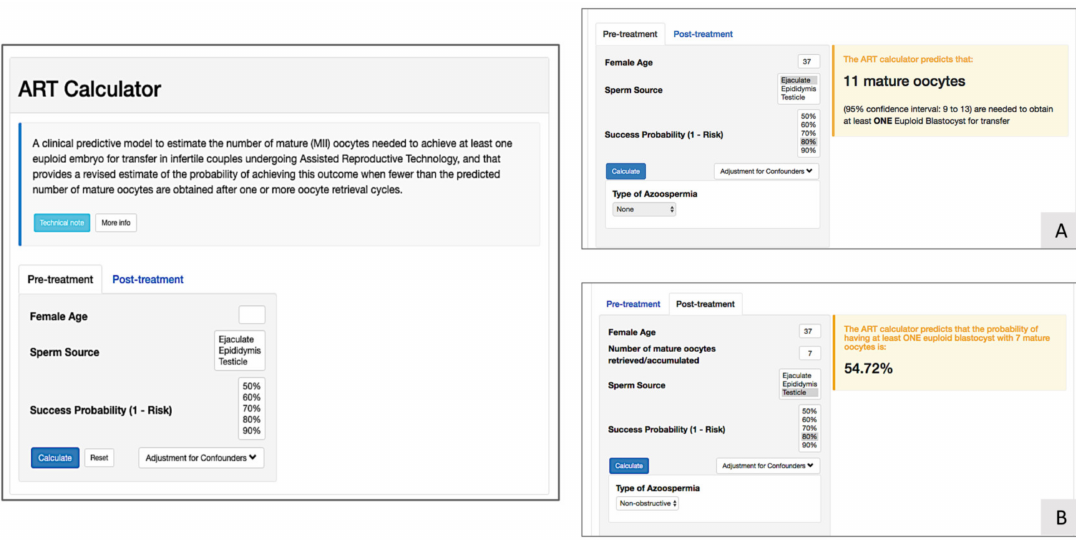
Figure 3. ART Calculator to estimate the minimum number of mature oocytes required to obtain at least one euploid blastocyst for transfer in infertile patients undergoing in vitro fertilization / intracytoplasmic sperm injection (IVF / ICSI) cycles. ( A ) Pretreatment, clinicians should input the patient age and the sperm source to be used for IVF / ICSI. If the option ‘Testicle’ is marked, then the type of azoospermia should be defined also. The probability of success is set by the user and indicates the chance of having ≥ 1 euploid blastocyst when the predicted number of mature oocytes is achieved. Its complement is the risk—that is, the chance of having no (zero) euploid blastocysts when the predicted number of oocytes is achieved. Once the button ‘Calculate’ is pressed, a text box will pop up on the right side of the screen, indicating the predicted minimum number of mature oocytes needed for obtaining at least one euploid blastocyst, with its 95% confidence interval. ( B ) Posttreatment, i.e., when fewer than the predicted number of mature oocytes are obtained after one or more oocyte retrieval cycles, clinicians should input the pretreatment information and the actual number of mature oocytes collected or accumulated. As in the pretreatment model, the probability of success is set by the user. Once the button ‘Calculate’ is pressed, a text box will pop up on the right side of the screen, indicating the predicted probability of achieving ≥ 1 euploid blastocyst with the number of mature oocytes available. Reprint from: Esteves, S.C.; Carvalho, J.C.; Bento, F.C.; Santos, J. A novel predictive model to estimate the number of mature oocytes required for obtaining at least one euploid blastocyst for transfer in couples undergoing in vitro fertilization / intracytoplasmic sperm injection: The ART Calculator. Front. Endocrinol. 2019 , 10 , 99, doi:10.3389 / fendo.2019.00099. This is an open-access article distributed